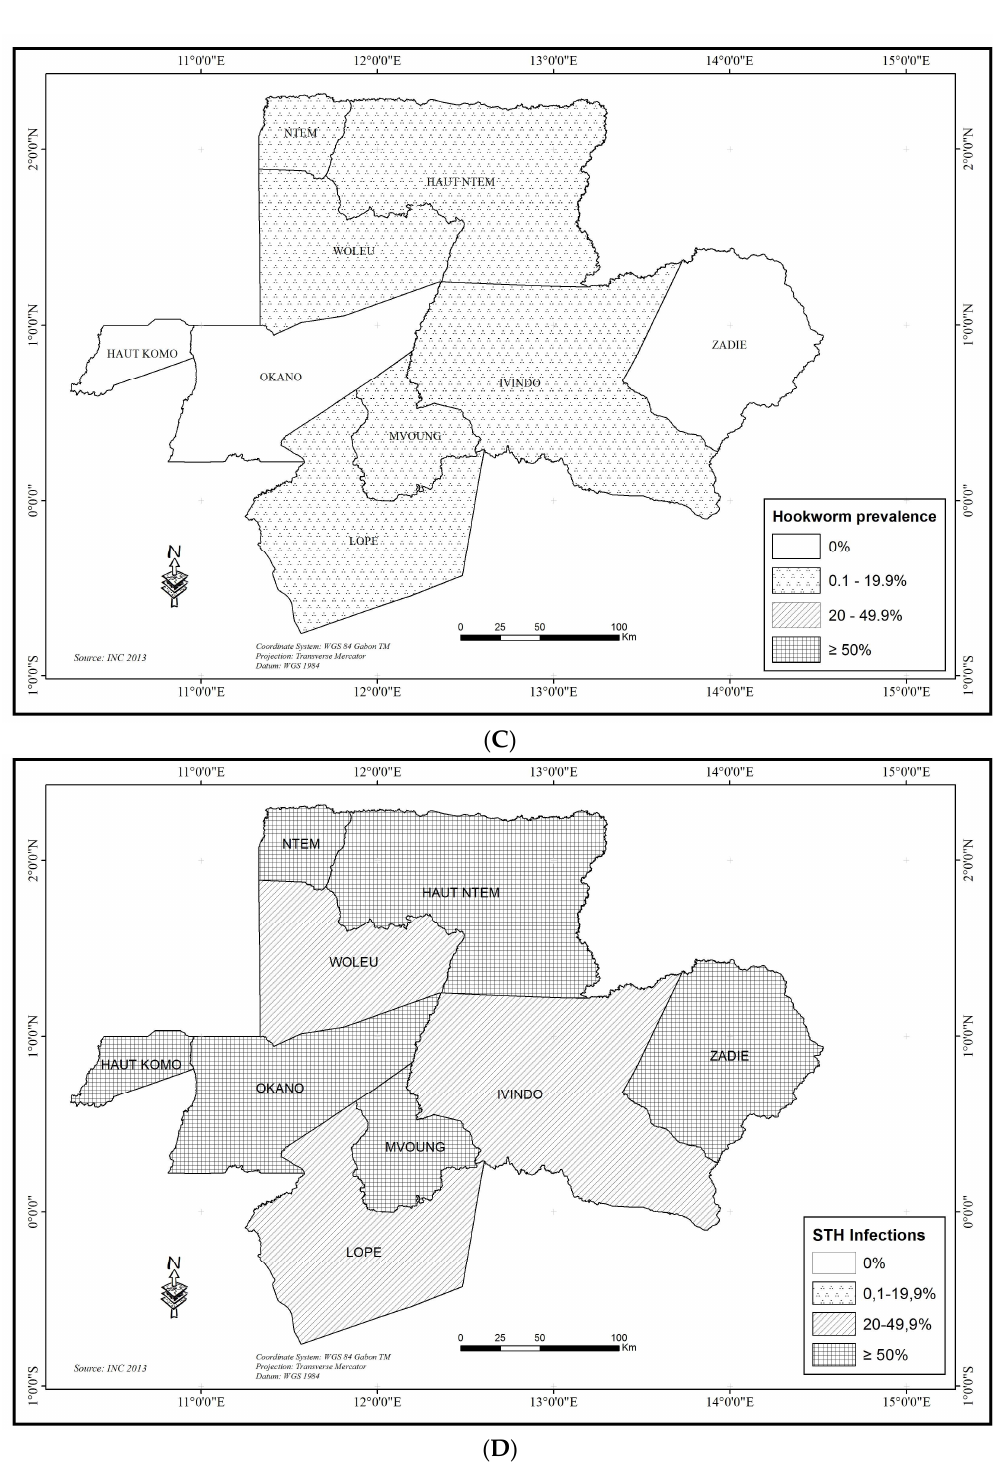
Figure 3. Map of prevalence levels for Soil Transmitted Helminthiasis at the department scale: (A ) Ascaris lumbricoides ; ( B ) Trichurus trichuira ; ( C ) Hookworm; and, ( D ) Combined STH.